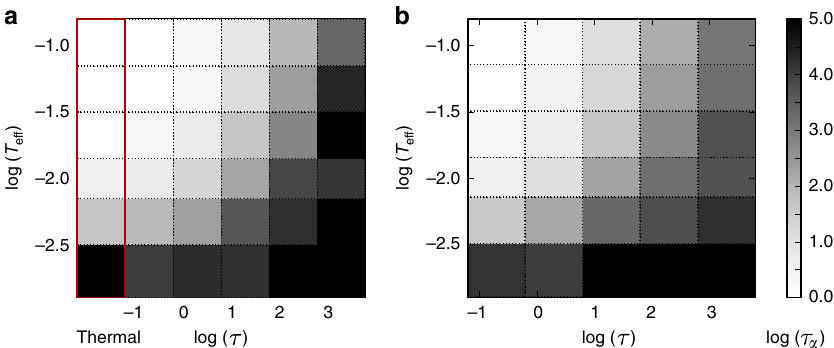
ζ v 2 τ = 2. The gray scale indicates 0 eff ¼